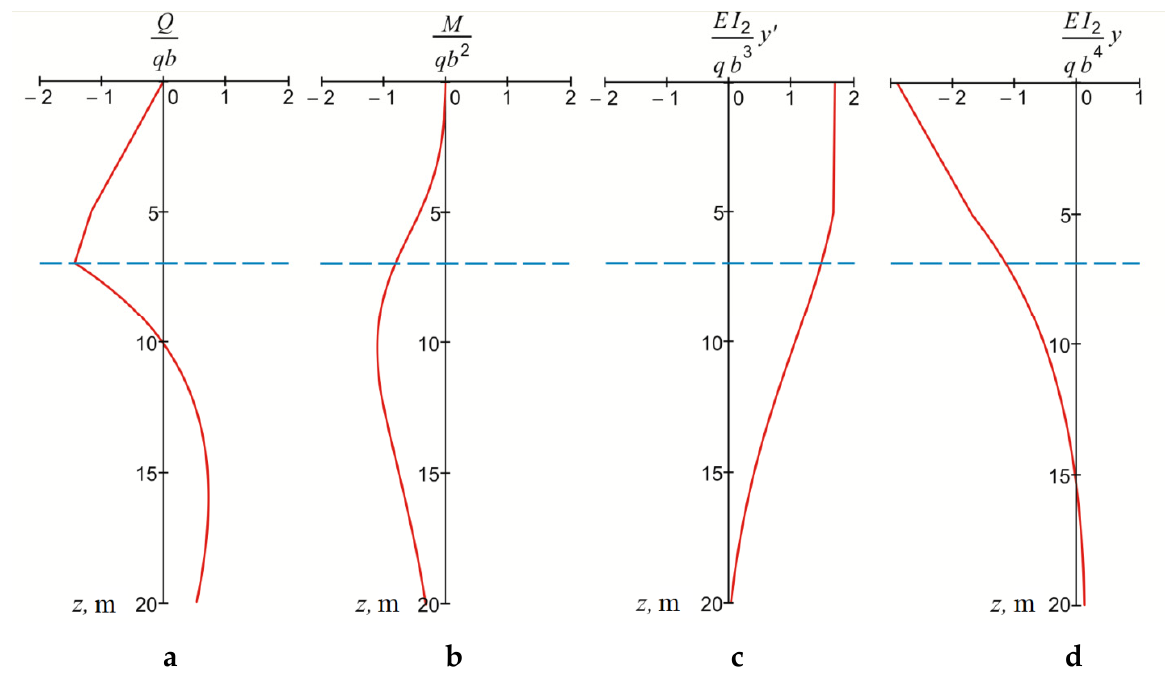
Figure 4. Diagrams of transverse force, bending moment, angle of rotation and lateral displacement at γ / b = 1; z = b = 7m —slickenside. ( a ) the distribution of the shear force; ( b ) the distribution of the bending moment; ( c ) the distribution of the angles of rotation of the cross sections of the system; ( d ) the distribution of transverse